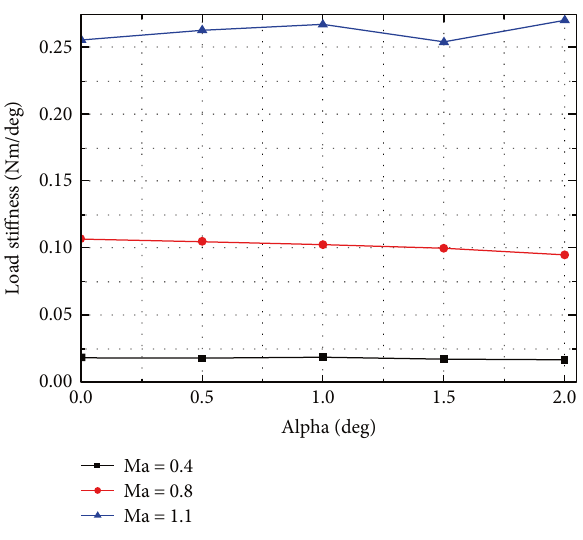
Figure 2: Changing curve line of the load sti ff